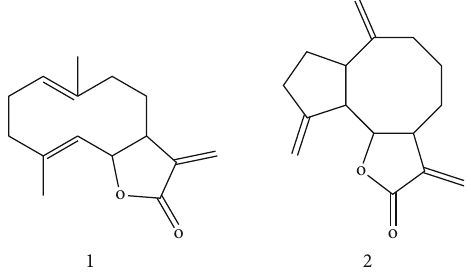
Figure 5: Structure of costunolide (1) and dehydrocostuslactone (2) isolated from